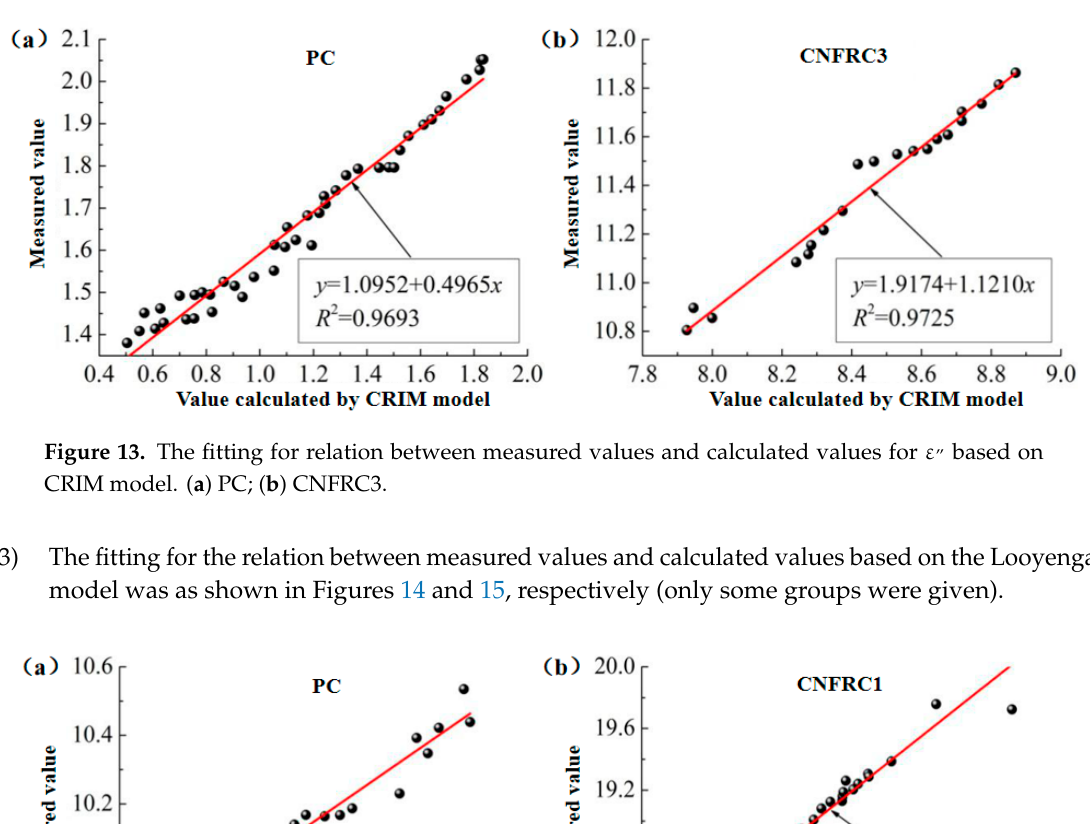
Figure 12. The fitting for relation between measured values and calculated values for ε , based on CRIM model. ( a ) PC; ( b ) CNFRC1.